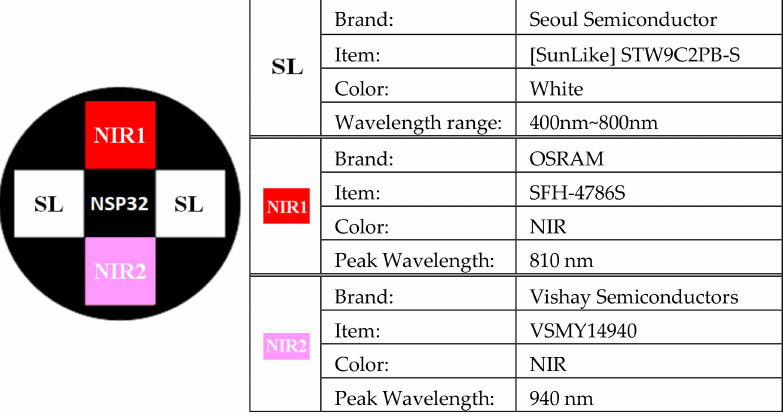
Figure 2. The light source configurations.